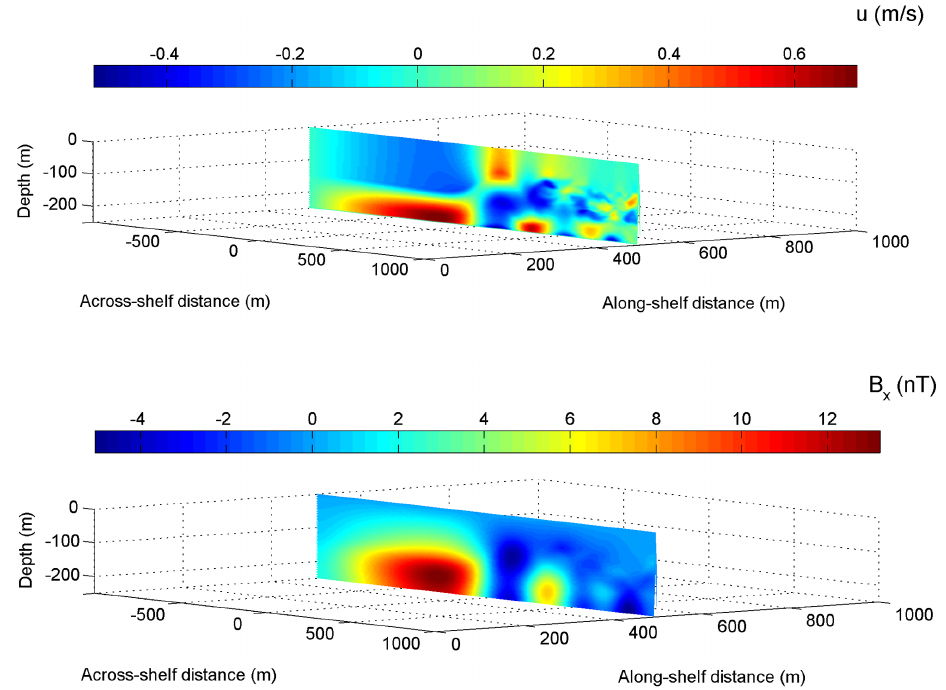
Figure 14. Top: side view of the velocity component in direction of wave propagation (in ms − 1 ) at time t = 2000s. Bottom: side view of the x component of the induced magnetic field (in nT) at time t =